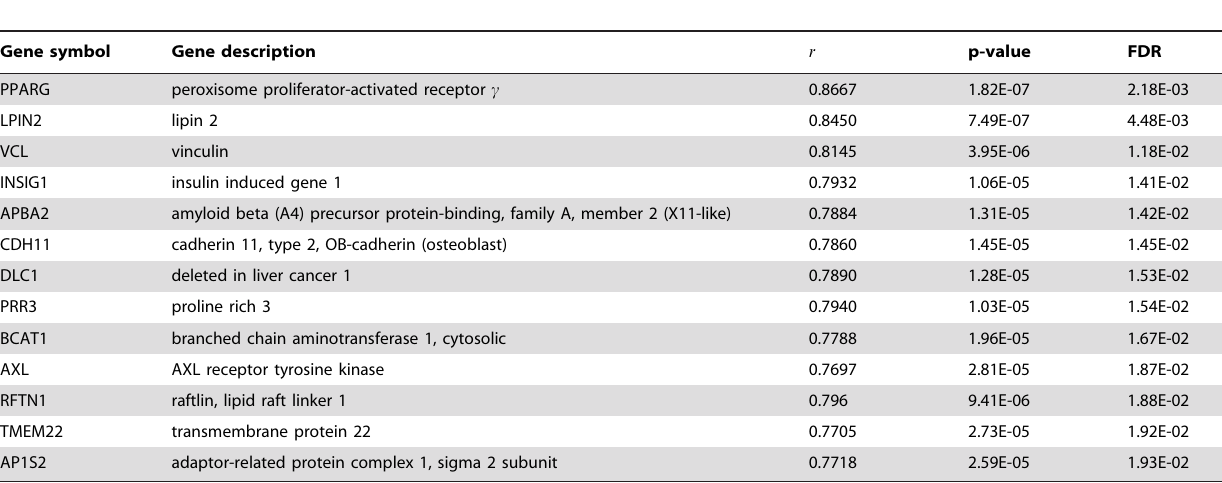
Table 2. Genes that best predict the size of the colony in terms of positive logistic relationship ( FDR v 0 : 02 ).